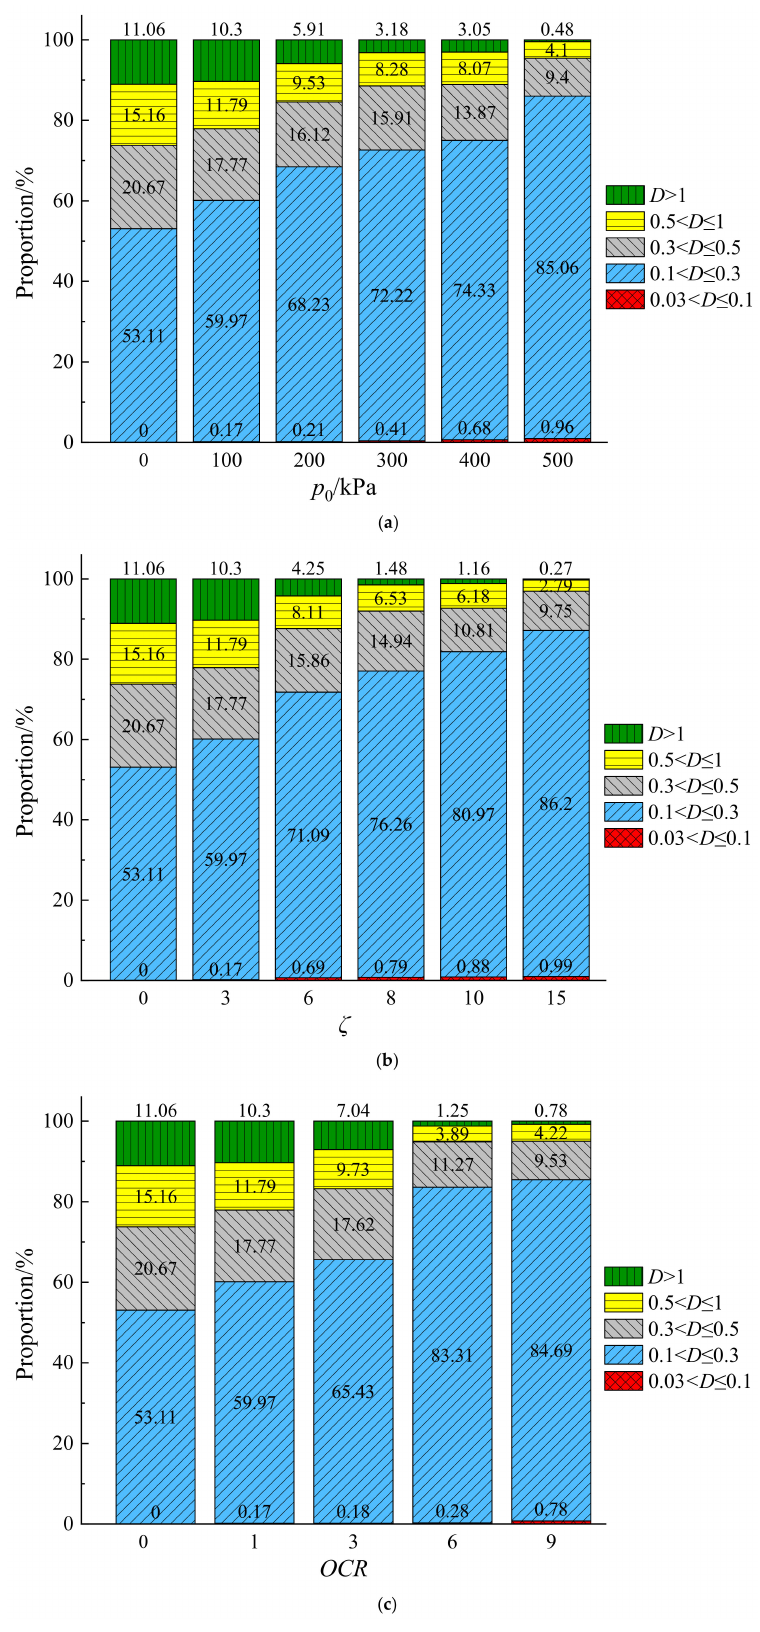
Figure 8. Changes in the distribution of equivalent pore diameters before and after loading under different test conditions: ( a ) SEM-A, ( b ) SEM-B, and ( c )